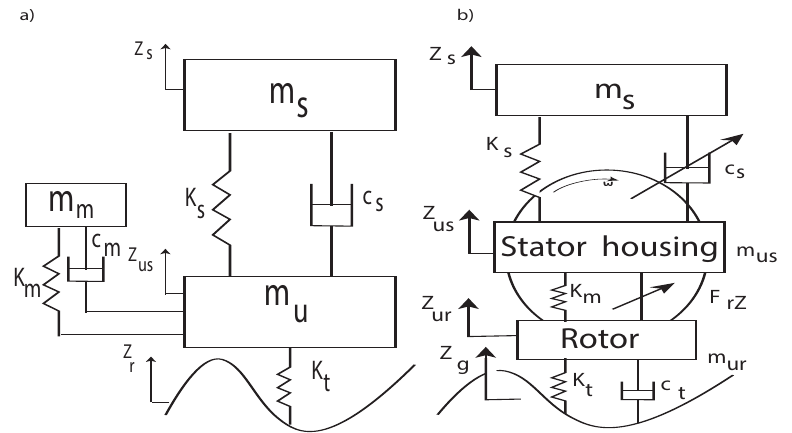
Figure 1. ( a ) Advanced-Dynamic-Damper-Motor (ADM), ( b ) In-wheel quarter of vehicle (QoV) three